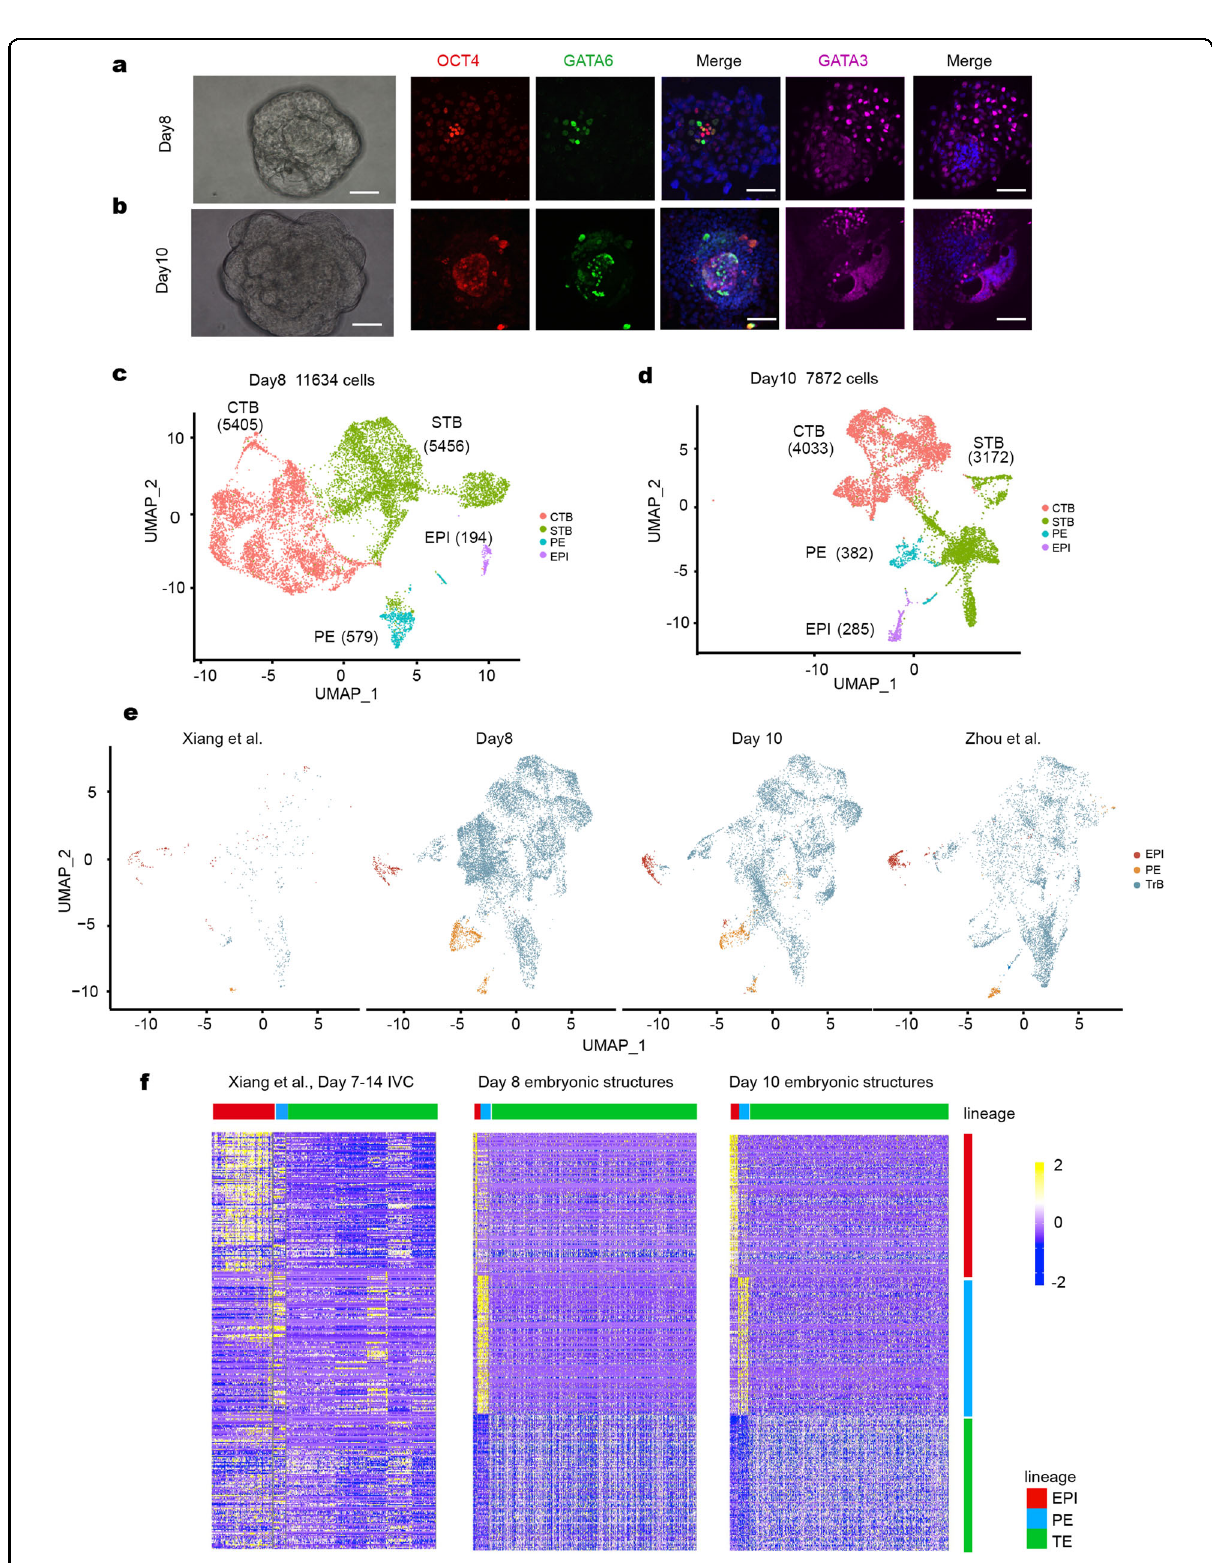
Fig. 4 Landscape of transcriptome in human embryo-like structures from blastoids on day 8 and day 10. a – d Immuno fl uorescence staining of EPI marker OCT4 and PE marker GATA6 in Day 8 ( a ) and Day 10 ( b ) embryonic structures. A UMAP plot analysis revealed 5 clusters in embryonic structures on day 8 ( c ) and day 10 ( d ), identi fi ed with assigned cluster names. e UMAP projection of integrated datasets showing our results of embryonic structures on day 8, day 10, and previous studies 32,33 (data of 7 – 14 d.p.f.). f Heatmap of lineage-speci fi c genes overlapped between a previous study 32 (data of 7 – 14 d.p.f. embryos) and this study on days 8 and